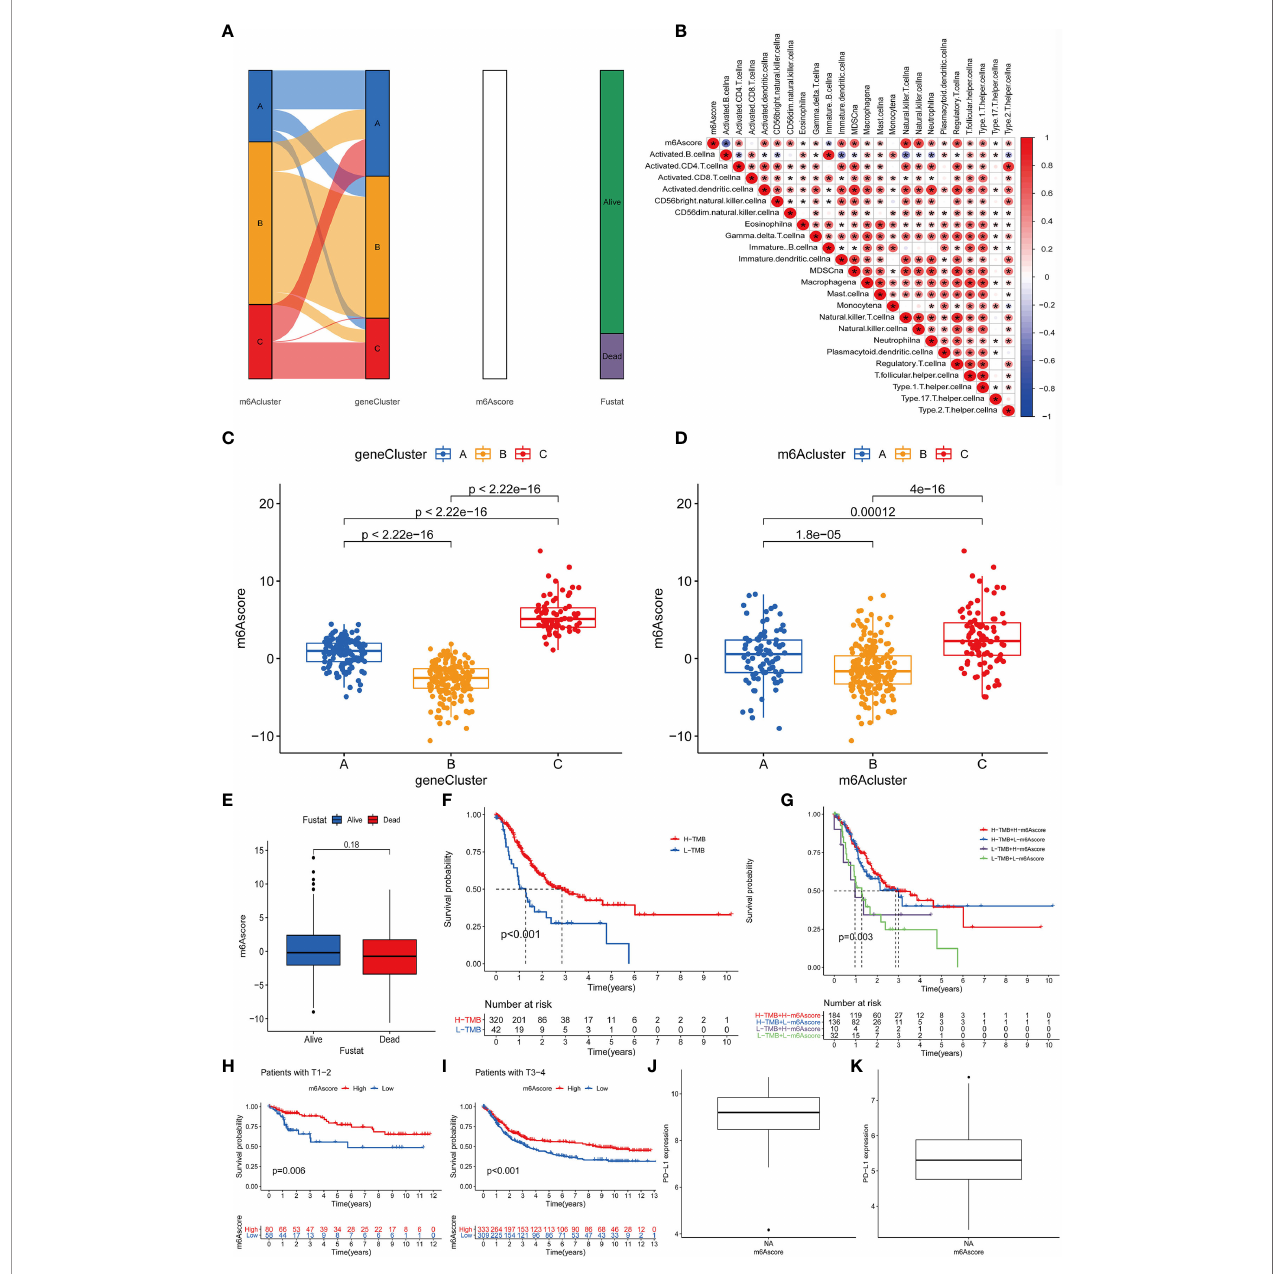
FIGURE 6 | Construction of m6A score and analysis of related modi fi cation patterns and clinical treatment effect of m6A score. (A) The alluvial map shows the changes of m 6 Aclusters, gene clusters, m 6 Ascore and survival status. (B) Using Spearman analysis, the correlation between m6score and known gene characteristics in the GSE87211 cohort. Blue is a negative correlation, and red is a positive correlation P values (*P <0.05; **P <0.01; ***P <0.001). (C) The difference of gene clusters among the three gene clusters in the GSE87211 cohort. The ordinate represents the m6A score while the abscissa shows the gene cluster A – C. Kruskal Wallis test was used to compare the statistical differences between the three gene clusters (P<0.001). (D) The difference of m 6 Acluster among the three gene clusters in the GSE87211 cohort. The ordinate indicates the m6A score while the abscissa shows the three m6A cluster A – C. Kruskal Wallis test was used to compare the statistical differences between the three gene clusters (P<0.001). (E) The difference of m6Ascore between different survival states in the GSE87211 cohort. (F) Kaplan-Meier curve of TMB high and low patients in the TCGA cohort, Log-rank test, P<0.001. The numbers of patients with high and low TMB were shown in the bottom. (G) Kaplan-Meier curve of patients with high and low TMB-m6Ascore in the TCGA cohort, Log-rank test, P=0.003. (H) Kaplan-Meier curve of patients with high and low m6Ascore in patients with T1-2 stage of rectal cancer. Log-rank test, P = 0.006. (I) Kaplan-Meier curve of patients with high and low m6Ascore in patients with rectal cancer T3-4 stage. Log-rank test, P<0.001. (J, K) PD-L1 expression difference in m6Ascore